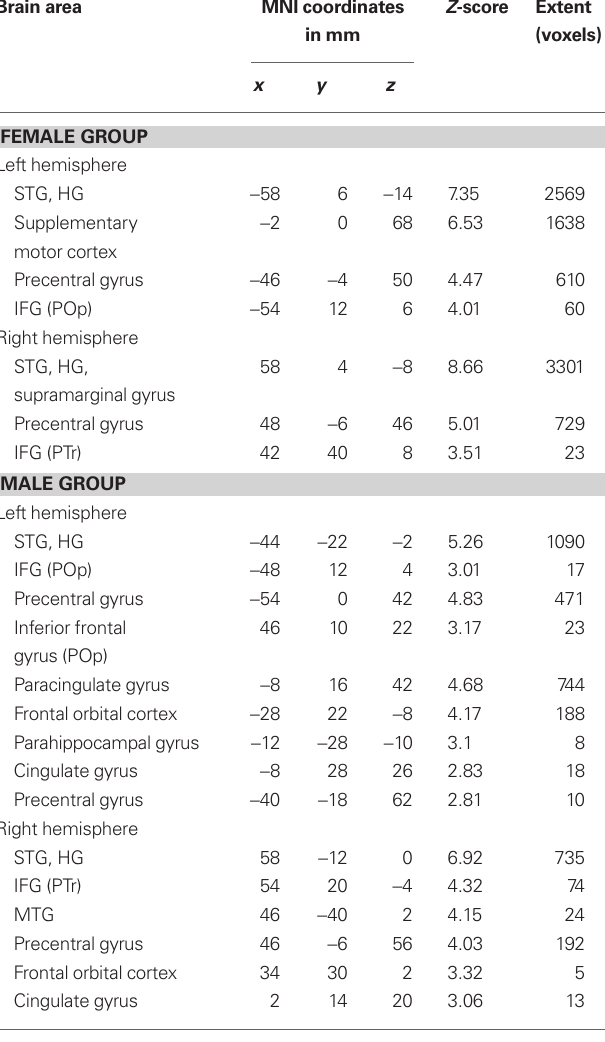
Table 3 | Mean coordinates (mm) of the areas functionally interconnected with the right Hg rOi during the contrast melody discrimination versus auditory control in the female group, and the male group. Only clusters with more than 10 voxels are